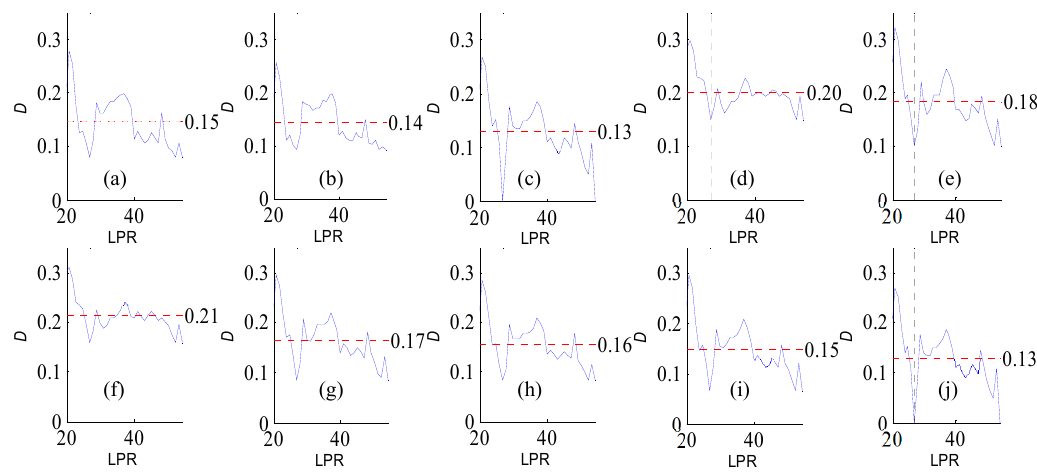
Figure A4. Variation of flow regime alteration degree (D) measured by the RVA with change in the length of post-impact flow time series (LPR) under a periodicity of 26 years. ( a ), ( b ), ( c ), ( d ), ( e ), ( f ), ( g ), ( h ), ( i ), and ( j ) correspond to pre-impact flow time series length = 19, 22, 26, 30, 33, 37, 41, 45, 48, 52 years, respectively. The abscissa value for the vertical dotted line is 26. The ordinate value for the horizontal dotted line is the mean degree of flow regime alteration in each subfigure.